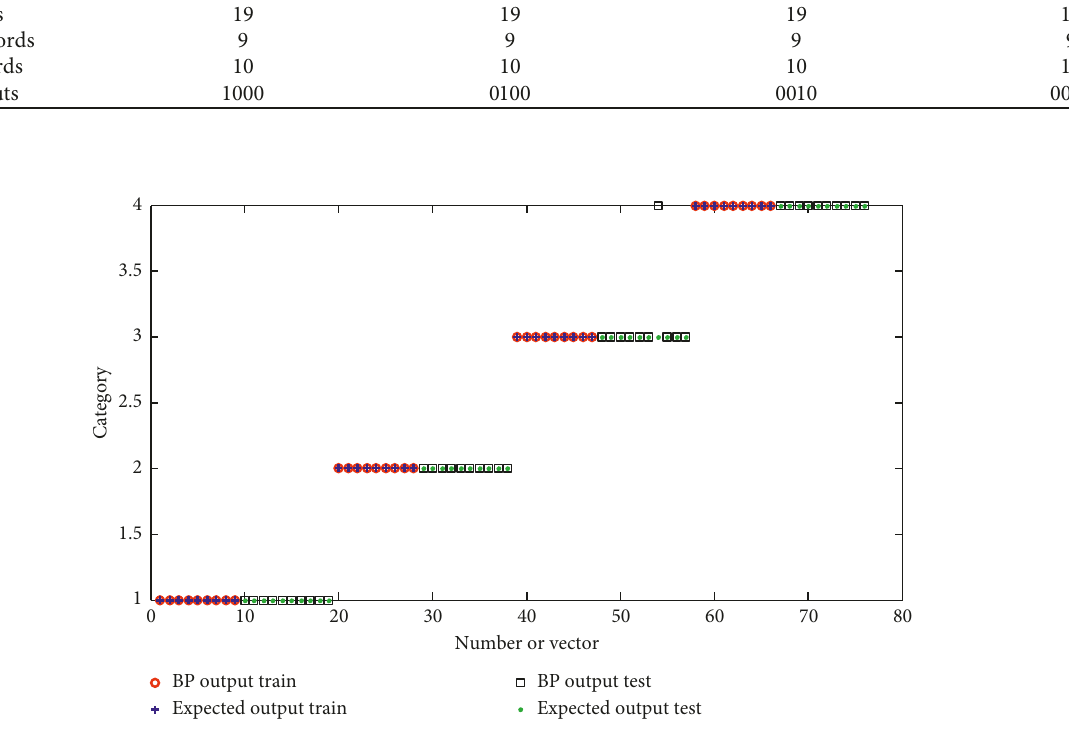
Figure 35: The classification results of gear signals. Table 9: Classification comparisons of CWRU database-adopted mode decomposition algorithm. Ref.